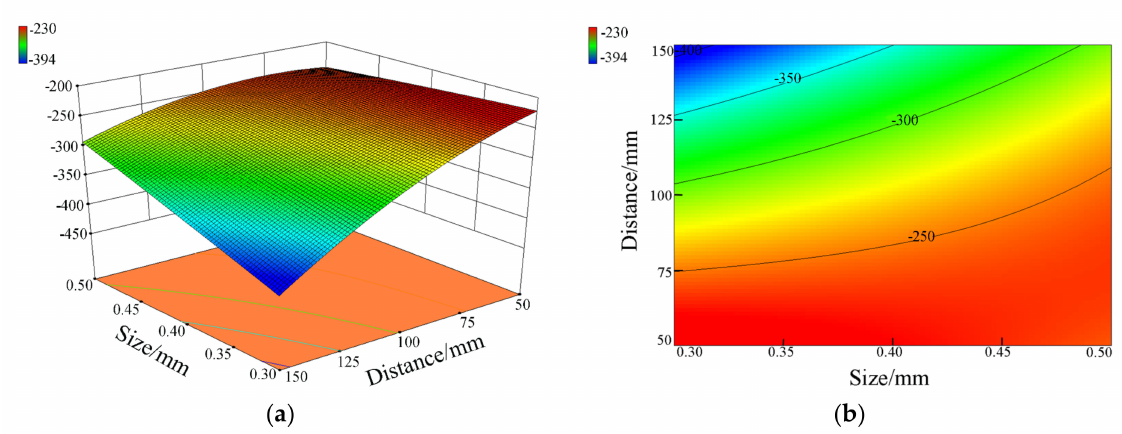
Figure 5. ( a ) Contour and 3D surface plot of stress in terms of projectile size and distance; ( b ) Contour.